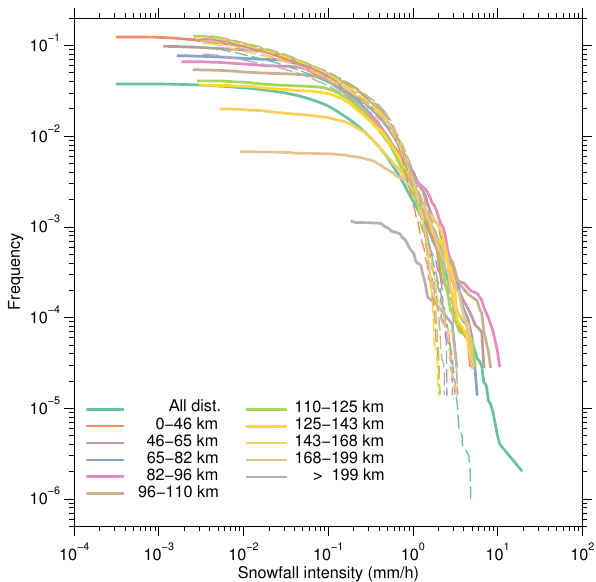
Figure 3. Empirical cumulative distribution functions for observa- tions of snowfall intensities from Swerad (solid lines) and Cloud- Sat (dashed lines), for various distances to the nearest ground-based